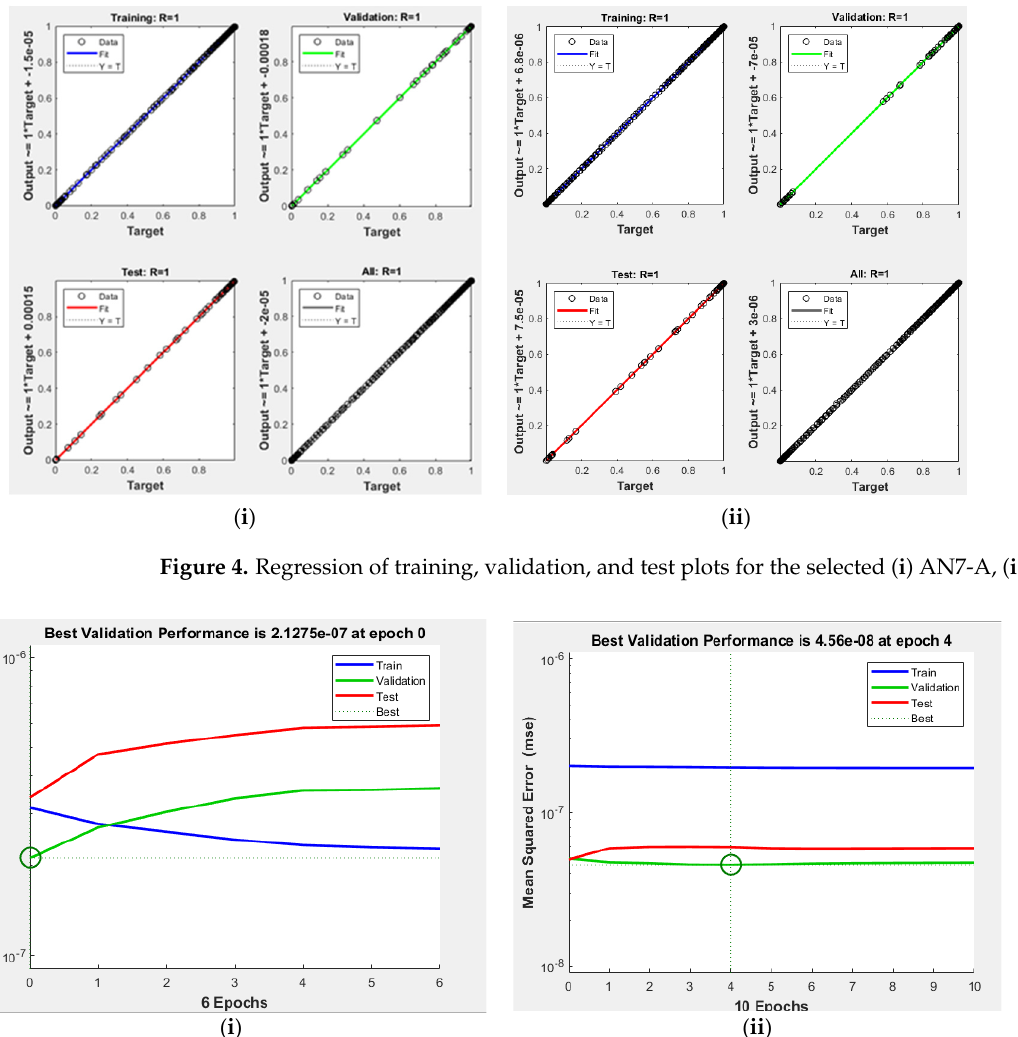
Figure 3. Topology of the selected AN7-A and AN7-B network.